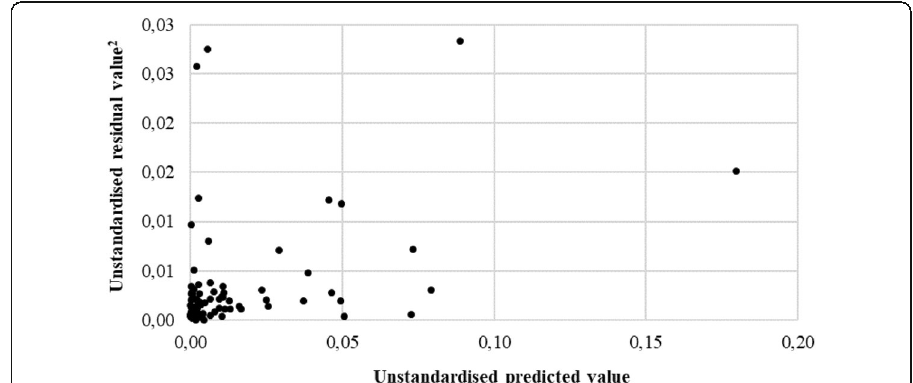
Fig. 1 Scatterplot test for